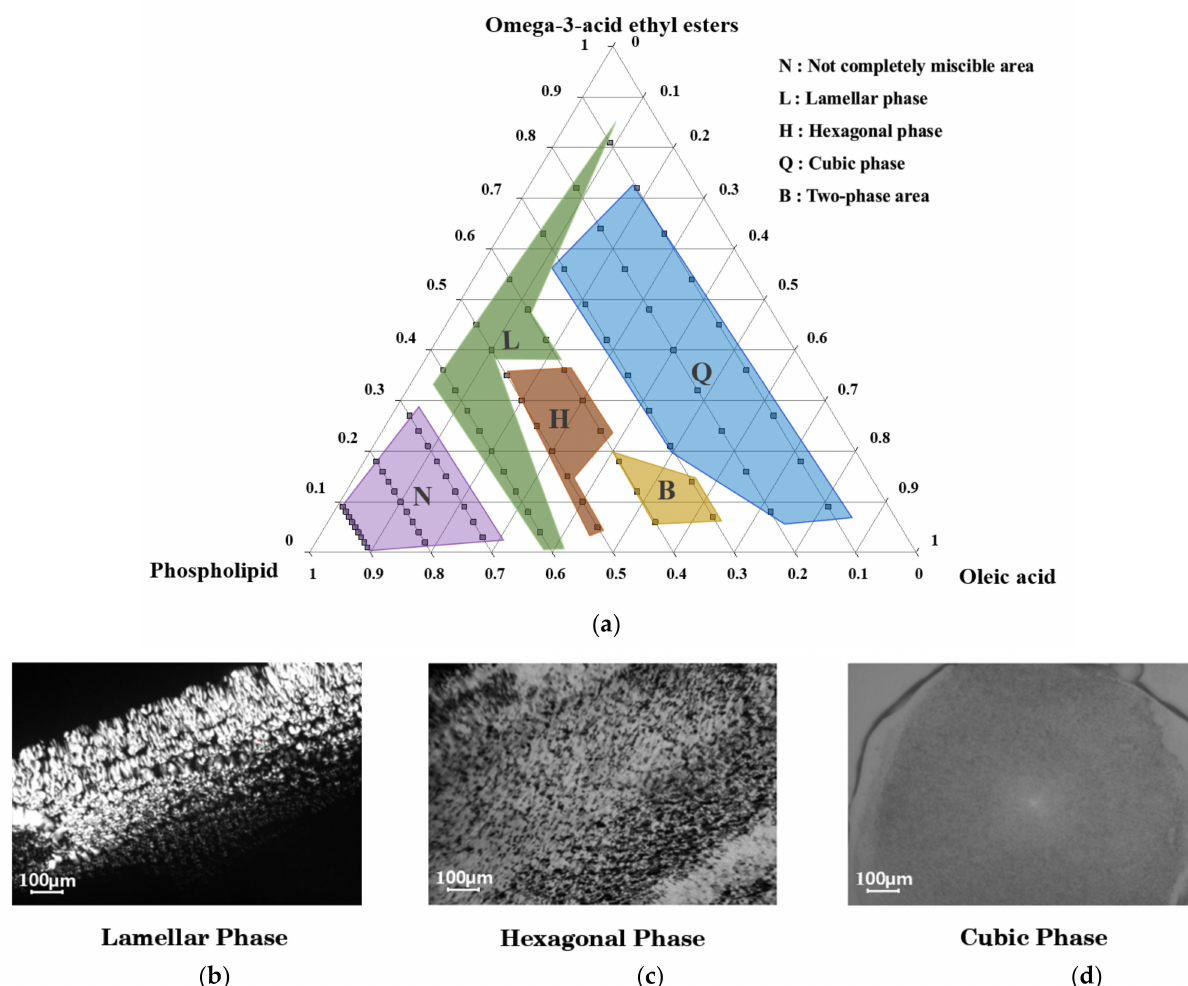
Figure 1. ( a ) Ternary phase diagram of Ω -3-acid ethyl esters ( Ω -3 EE), oleic acid, and phospholipids in water at 25 ◦ C. ( b ) Lamellar, ( c ) hexagonal, and ( d ) cubic structures observed via polarized optical microscopy, showing the morphology of liquid crystalline